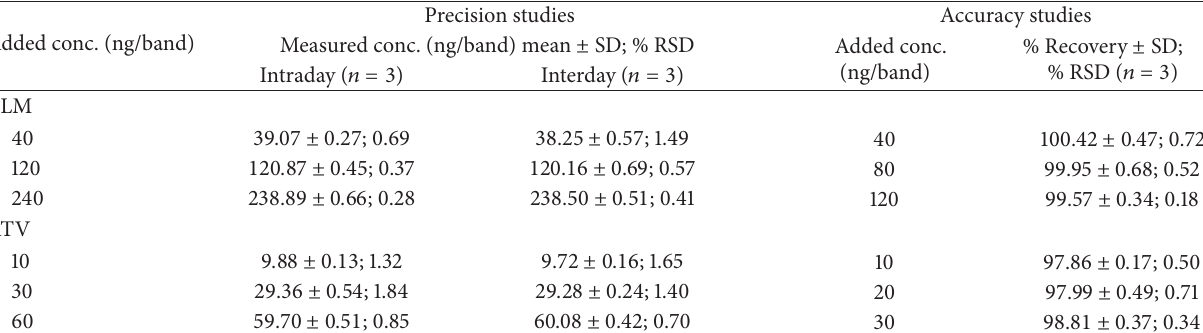
Table 6: Intraday and interday precisions and accuracies by HPTLC method. Precision studies Accuracy Added conc. (ng/band)